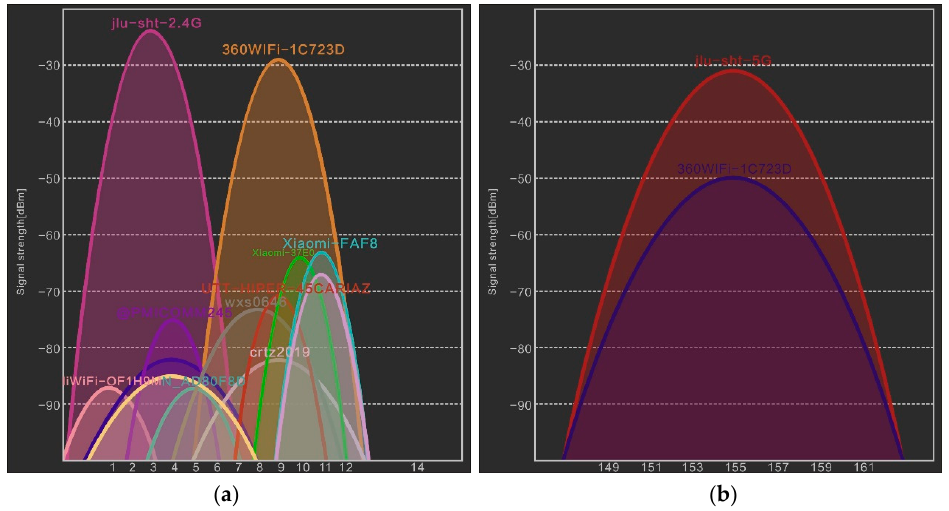
Figure 2. ( a ) Noise interference of Wi-Fi (2.4G) channel; ( b ) Noise interference of Wi-Fi (5G) channel noise interference.